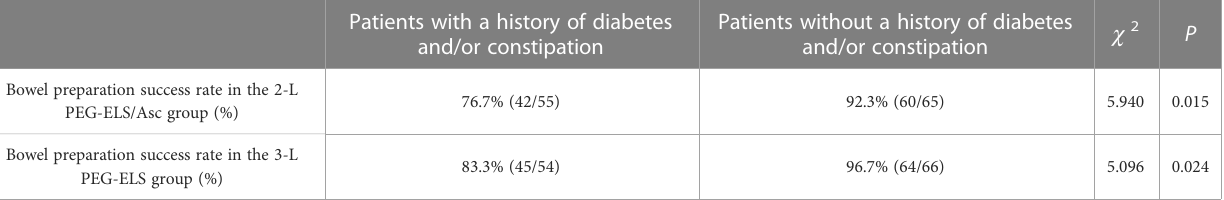
TABLE 4 Evaluation of bowel cleansing effect of diabetes and constipation patients between the two groups.